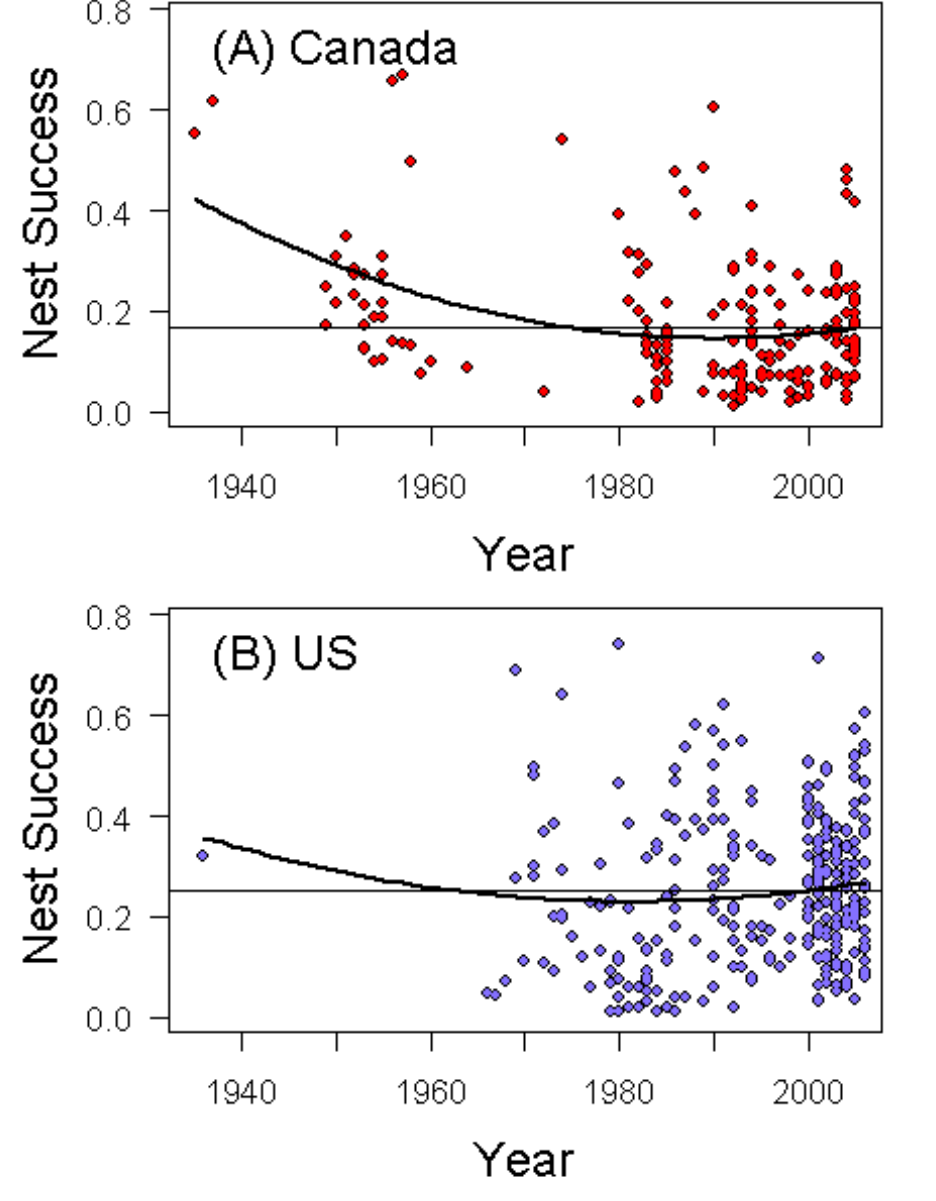
Fig. 2 . Temporal trends in nest success in the Prairie Pothole Region of (A) Canada and (B) the United States. Nest success estimates were collected from studies based at sites in Alberta, Saskatchewan, Manitoba, North Dakota, and South Dakota from 1935 to 2006. The solid lines in panels A and B indicate the model-averaged predicted values from a series of models depicting nest success as a function of latitude, longitude, country (Canada/United States), year, year as a quadratic term, and the interactions of the above. Thin horizontal lines represent the mean value of all nest success estimates for each country (0.16 in Canada, 0.25 in the United